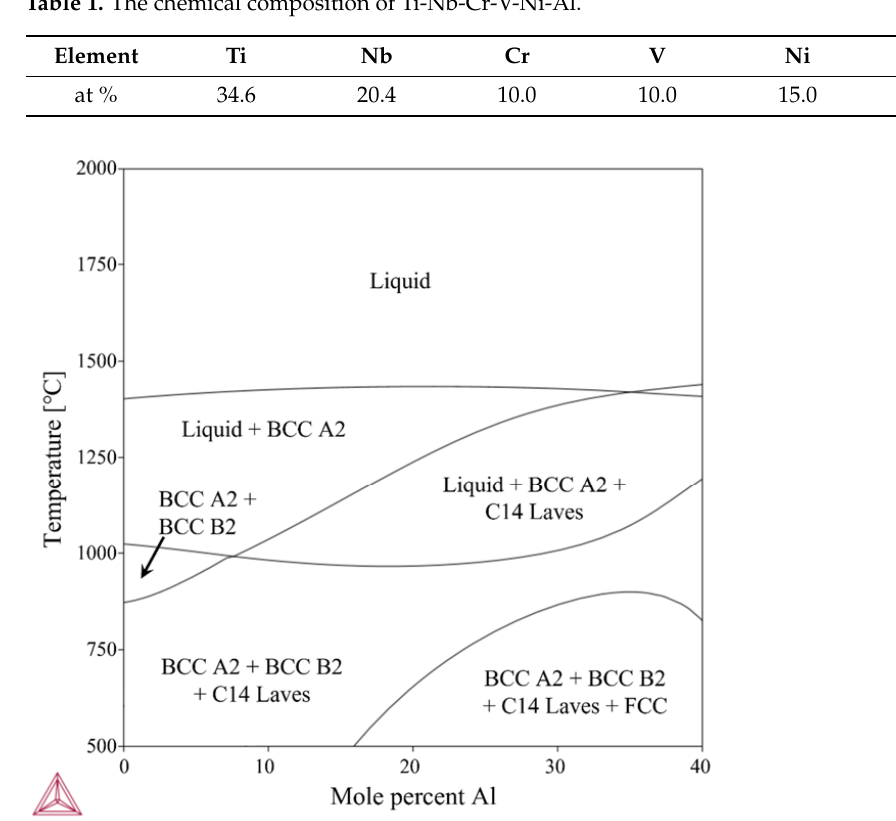
Table 1. The chemical composition of Ti-Nb-Cr-V-Ni-Al.